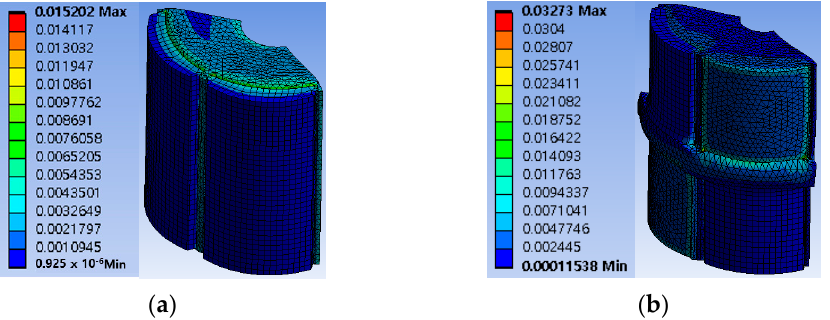
Figure 13. Mechanical stiffness analysis: ( a ) conventional model, ( b ) intersect center magnet CP.